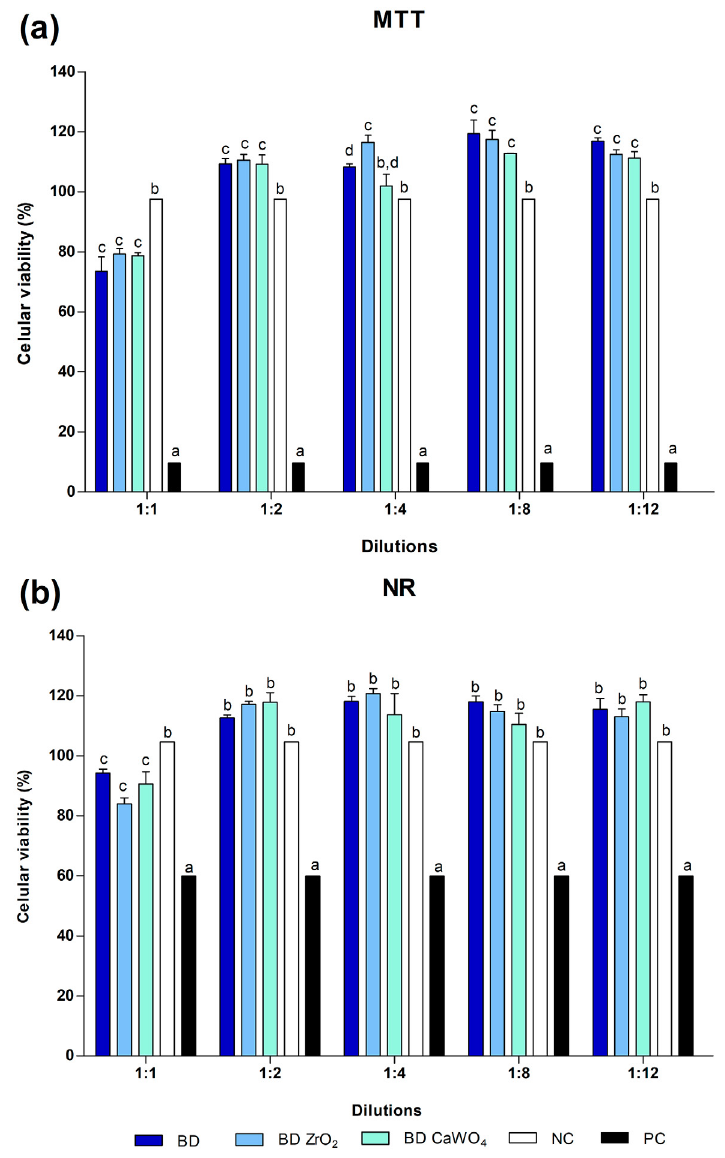
Figure 3- Saos-2 cell viability evaluated by (a) methyl-thiazol-tetrazolium (MTT) and (b) neutral red (NR) assays, after 24 hours of exposure to BD, BD ZrO and BD CaOW and controls. At 1:1 dilution, all material groups had lower cell viability than culture medium 2 4 (negative control). At 1:2, 1:4, 1:8 and 1:12 dilutions, the cement cytocompatibility was greater than or similar to the negative control. Bars with different letters represent significant difference between groups in each dilution. BD=Biodentine; BD ZrO zirconium oxide; BD CaWO =BD with addition of 15% calcium tungstate; NC=negative control; PC=positive 4